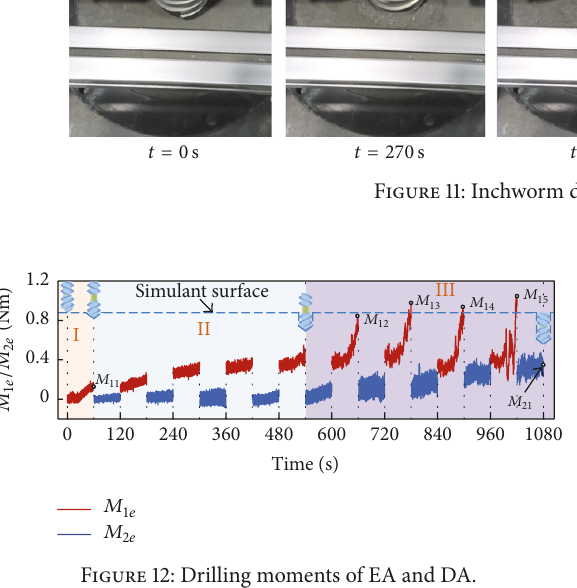
Figure 12: Drilling moments of EA and DA.